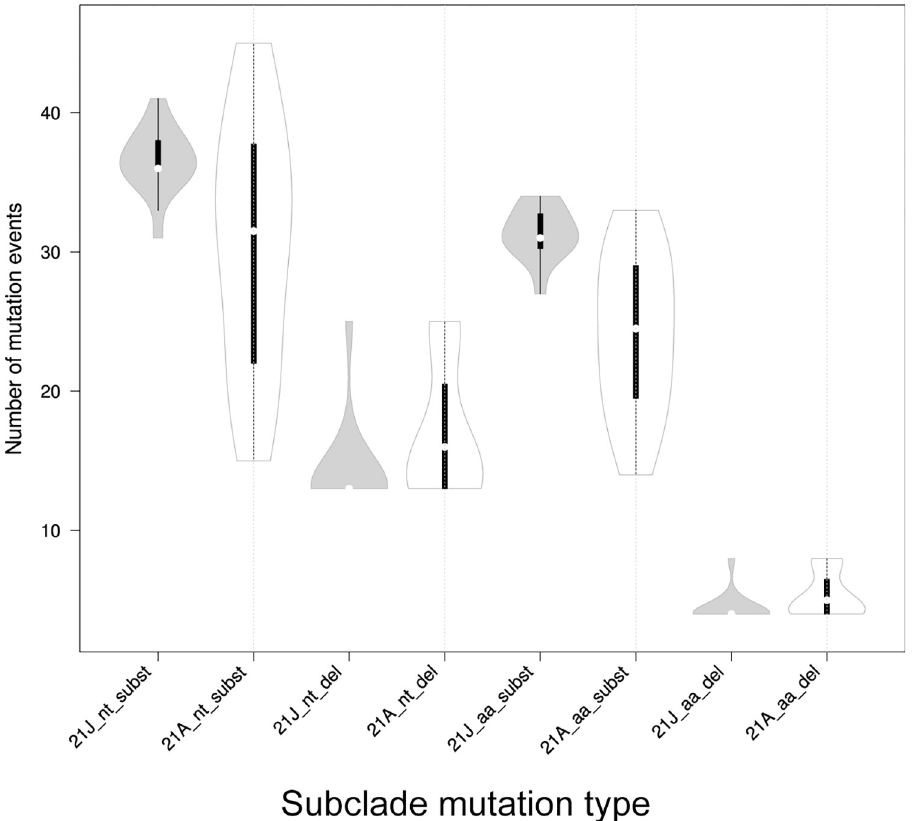
Fig 8. Distribution of mutation types in the Delta variant subclades 21A (n = 18) and 21J (n = 14). The dots mark the median values, the bold bar marks interquartile range. nt–nucleotide; aa–amino acid.